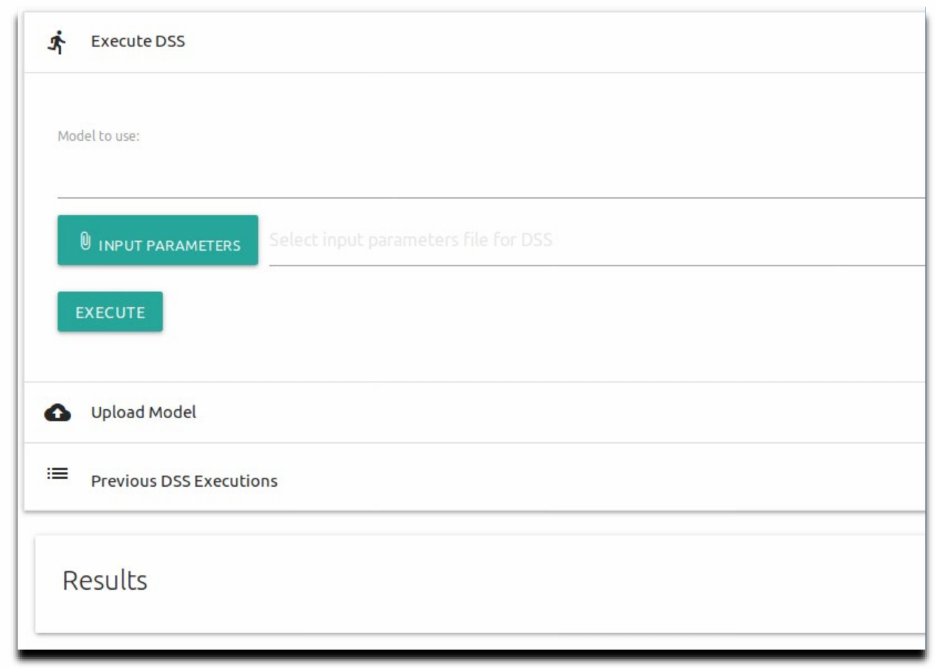
Figure 4. The web-based user interface of the